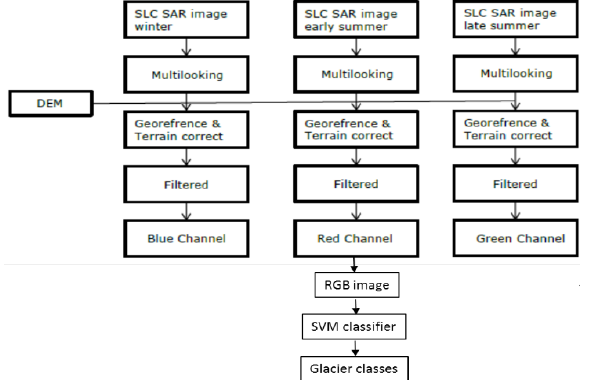
Figure 5 Glacier facies mapping approach (Thakur et al., 2016; Sood, 2015).